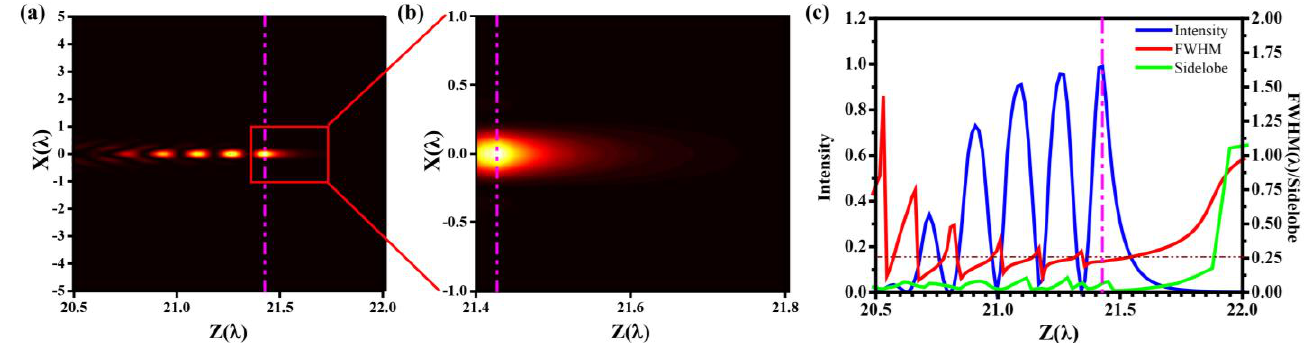
Figure 2. The design results: characterization of solid immersion lens. ( a ) Intensity distribution of the light beam along the propagation direction. ( b ) Intensity distribution near the silicon – air interface. ( c ) Intensity (blue line), FWHM (red line) and side lobe (green line) electric field curves in the propagation direction.